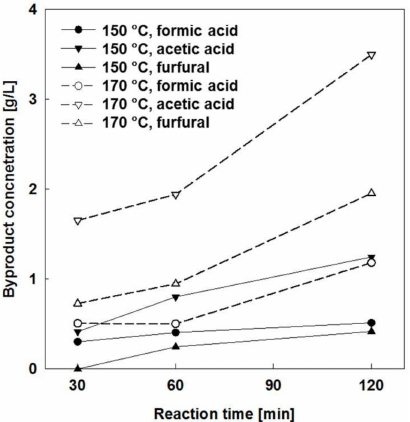
Figure 2. Effects of reaction temperature and time on concentrations of byproducts in liquid hydrolyzate. Reaction conditions: 40% ethanol concentration and 10